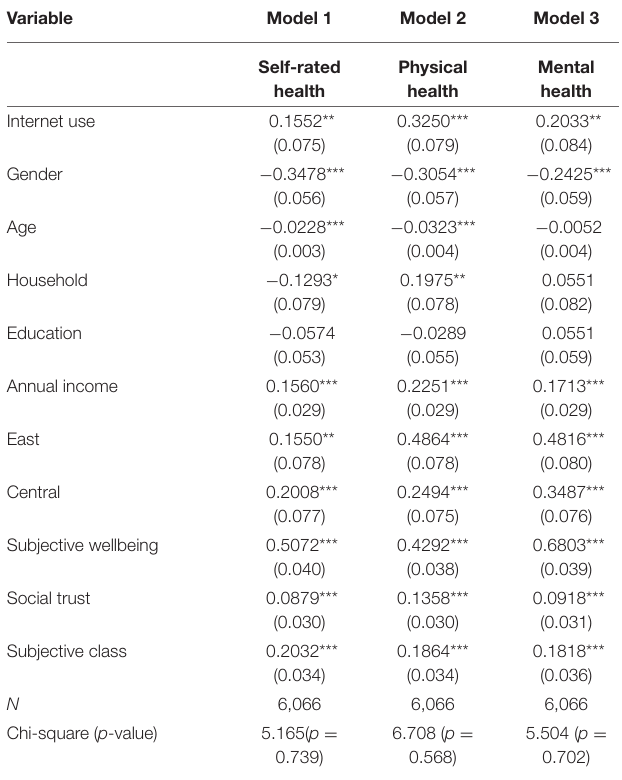
TABLE 2 | Logistic regression estimation results of Internet use on multi-dimensional